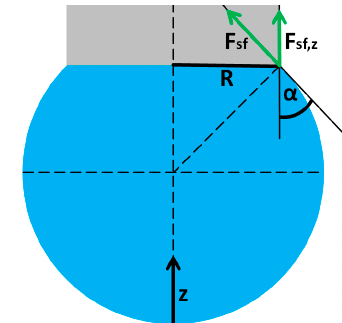
Figure 1. Sketch to visualize the different geometric characteristics used in Equation (2). The vertical axis, labeled as z -axis, is set to be positive in the upwards